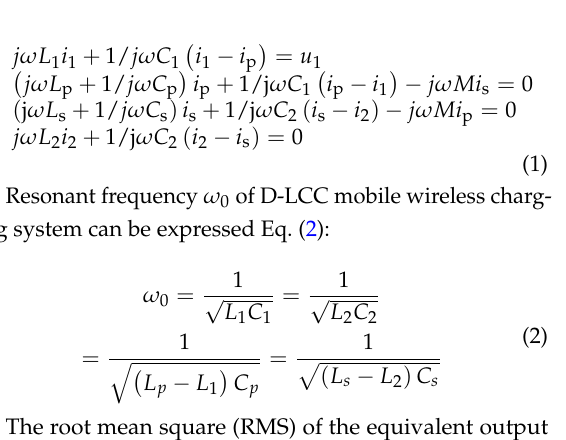
Fig. 2. Circuit topology diagram of D-LCC mobile wireless charging system